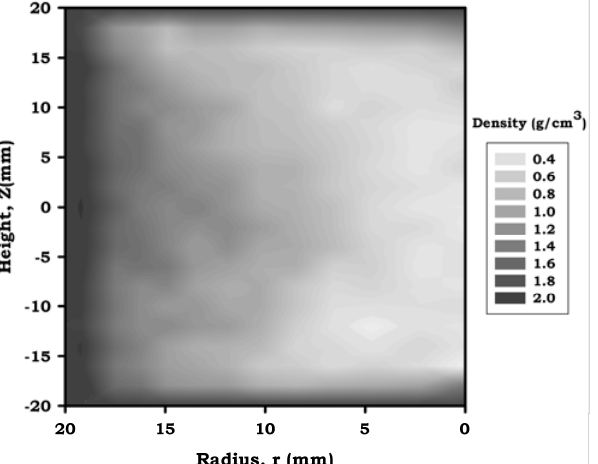
Figure 5. Density maps obtained by the SSDD method for the 40/40 mm sample with bulk densities 660 kg/m 3 .